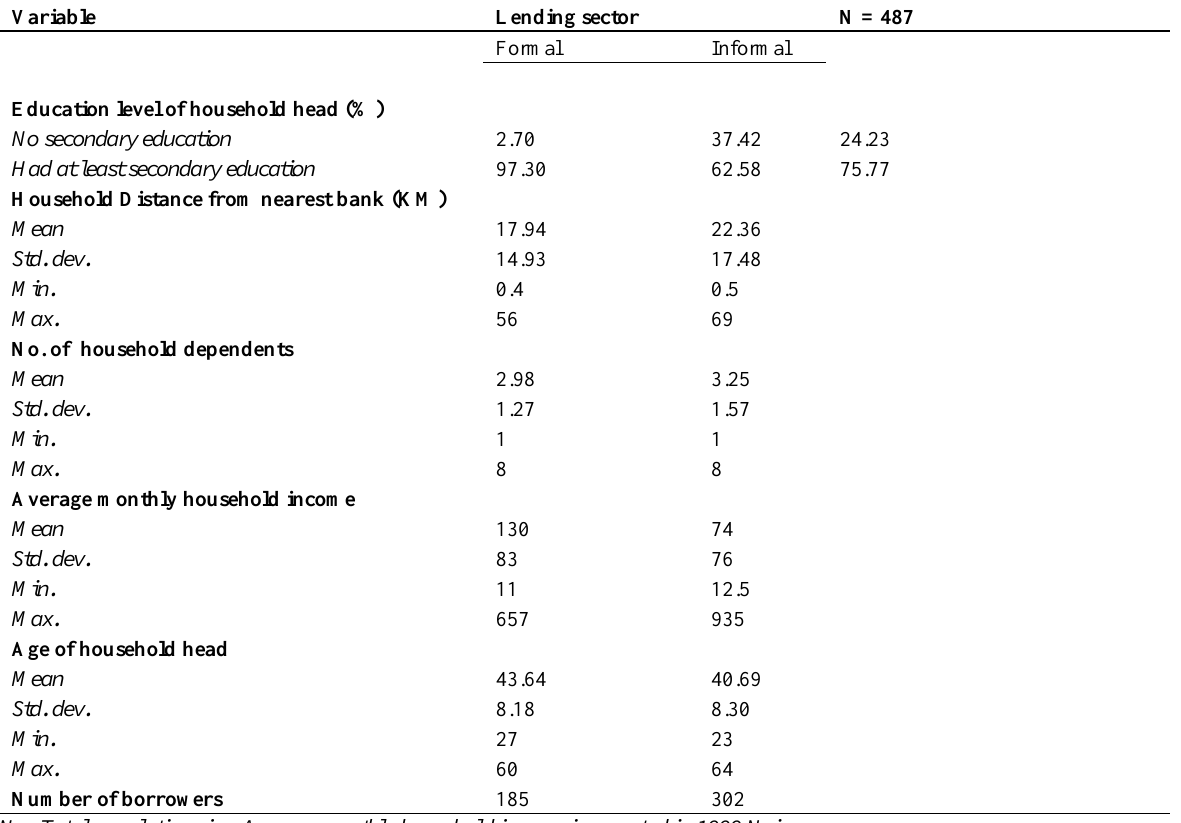
Table 2: Socio-economic profiling of respondents by lending sector